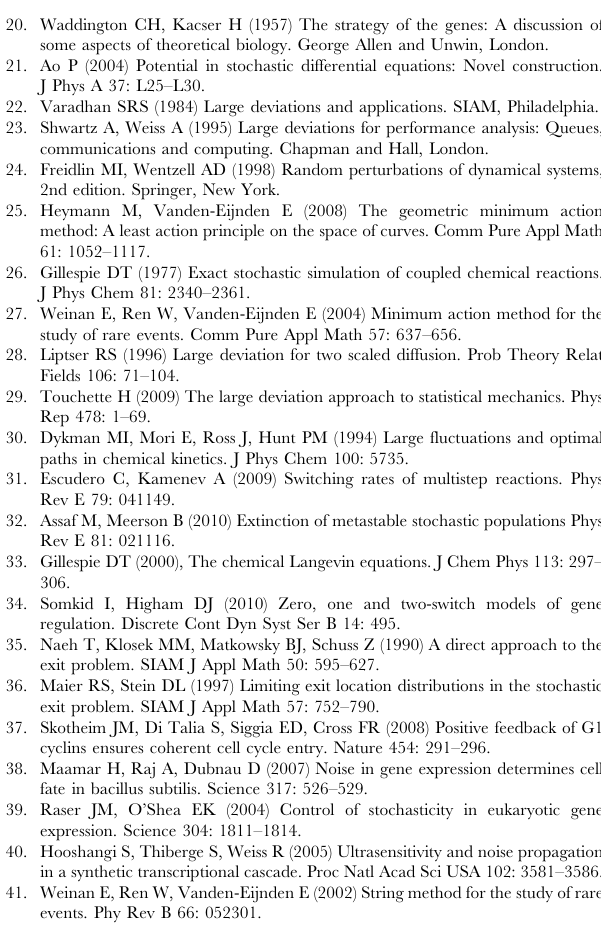
Figure S1 The network design of three synthetic transcriptional cascades.